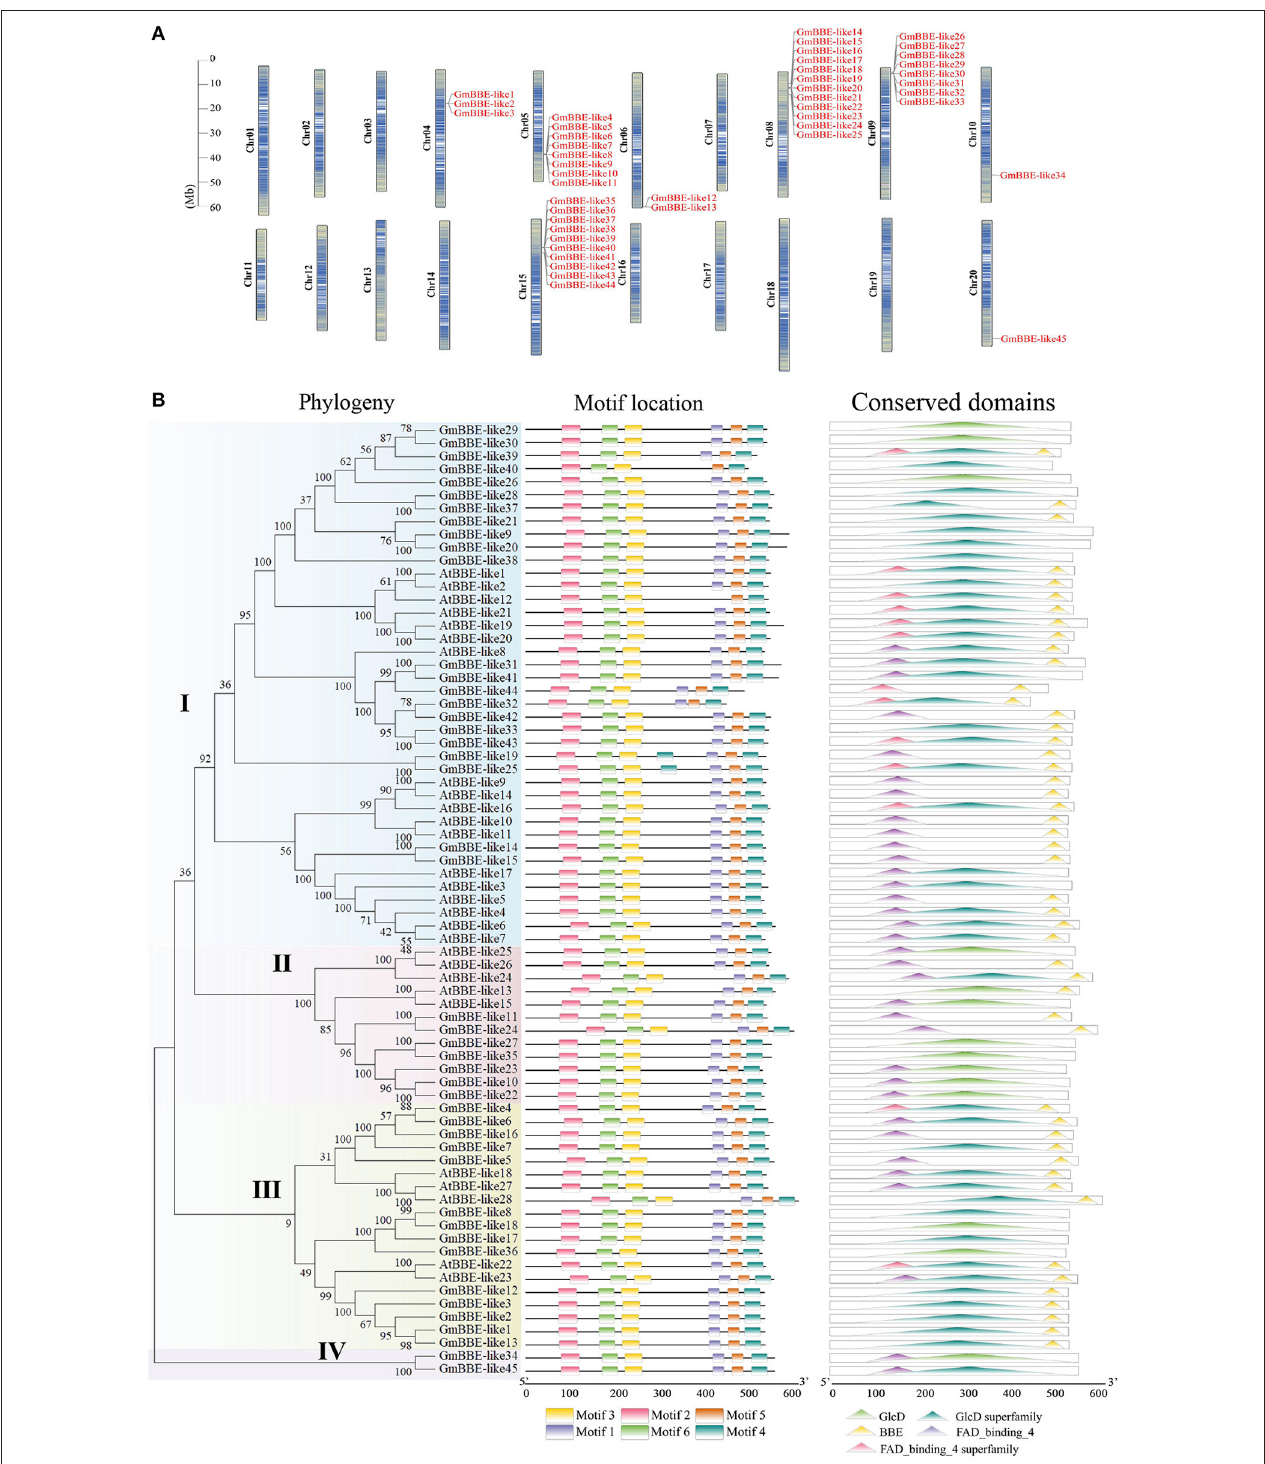
FIGURE 1 | Genes chromosome distribution, phylogeny, and conserved motifs/domains of GmBBE-likes. (A) The location of GmBBE-like genes in chromosomes. The size of a chromosome is indicated by its relative length and the figure was produced using the TBtools software; (B) The phylogenetic analysis and conserved motifs/domains of GmBBE-likes. The phylogenetic tree was created using the MEGA-X program with neighbor-joining method (1000 bootstrap replicates) based on BBE-like protein sequences from soybean and Arabidopsis. The bootstrap values are indicated for major branches as percentages. Conserved motifs and conserved domains in the BBE-like proteins as revealed by MEME